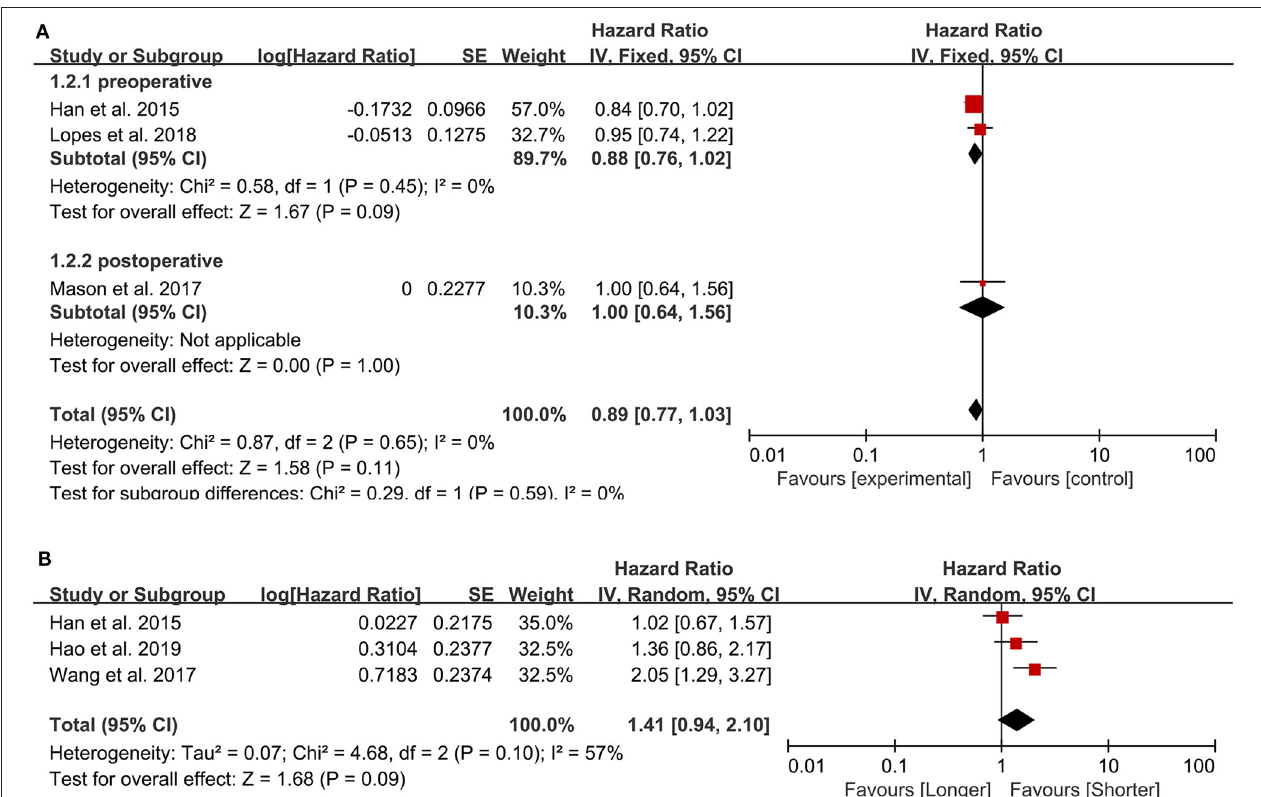
FIGURE 3 | Pooled hazard ratio (HR) and 95% confidence intervals (CIs) for OS in GBM patients. (A) HR and 95% CIs of the count of lymphocytes. The peripheral lymphocyte count did not have prognostic value in patients with GBM both in total group analysis and subgroup analysis. (B) HR and 95% CIs of PLR. The PLR was not associated with the prognosis of GBM